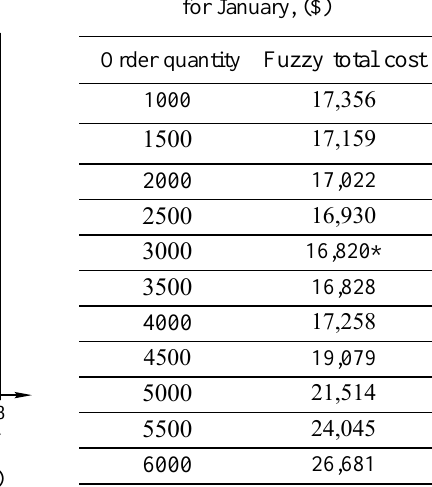
Table 4. Fuzzy total costs